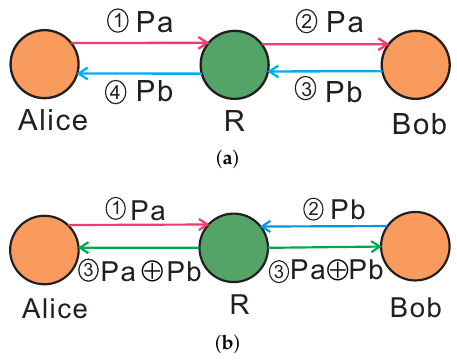
Figure 2. Illustration of “Alice-Bob structure” network coding. ( a ) Transmission without network coding; ( b ) Transmission with network